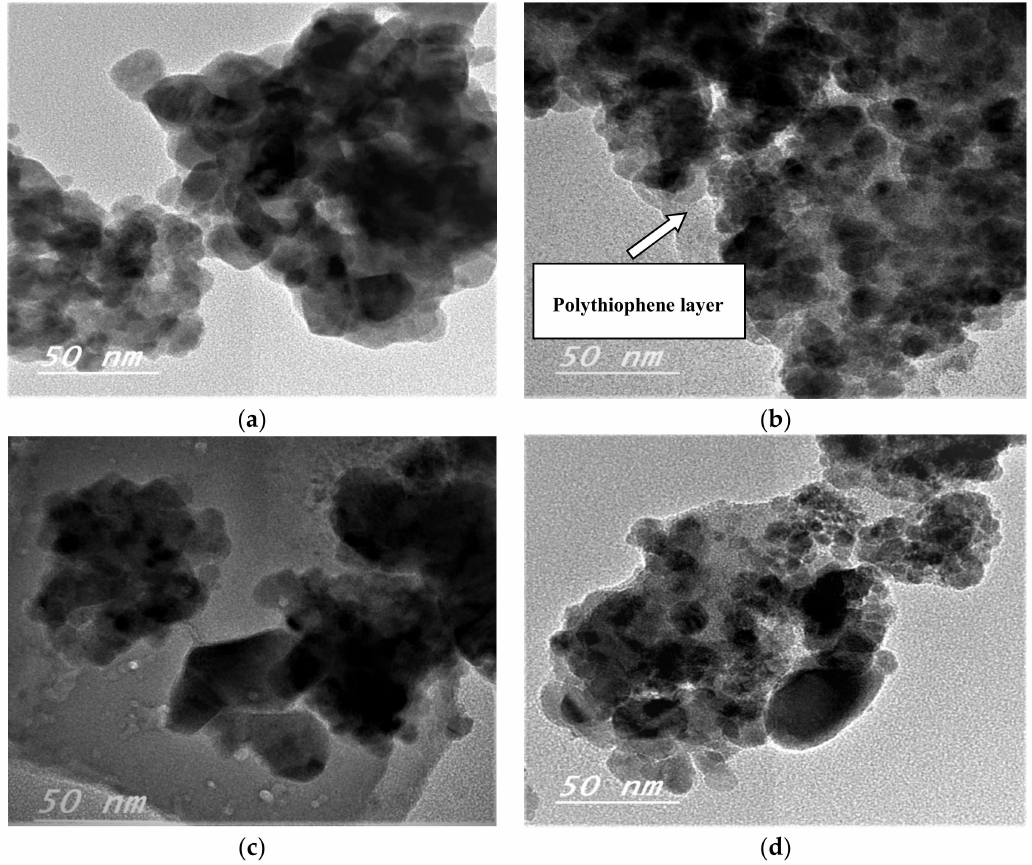
Figure 3. High-resolution transmission electron microscopy (HRTEM) images before adsorption for [A] (CuFe 2 O 4 ( a ) and ( b ) CuFe 2 O 4 @Polythiophene composite) and after Hg 2 + adsorption [B] (CuFe 2 O 4 ( c ) and ( d ) CuFe 2 O 4 @Polythiophene